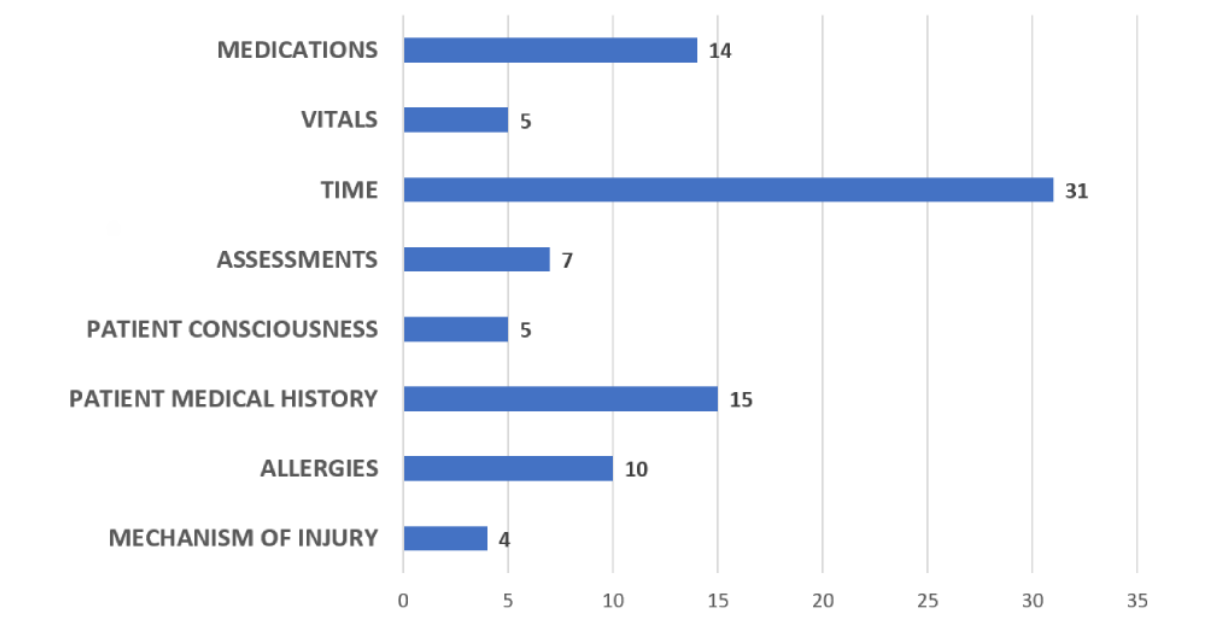
Figure 1. Content of clarifying questions in the trauma